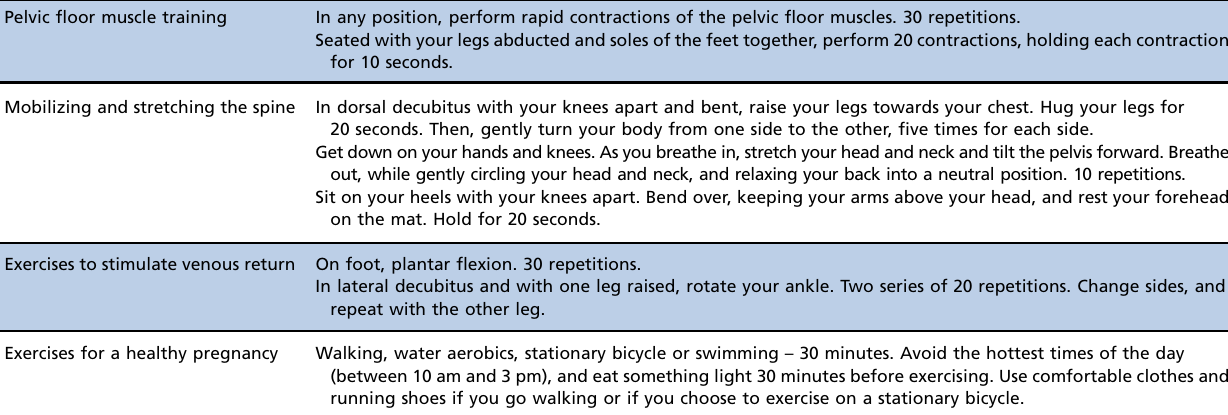
Table 3 - Instructions for exercises to be performed at home. Pelvic floor muscle